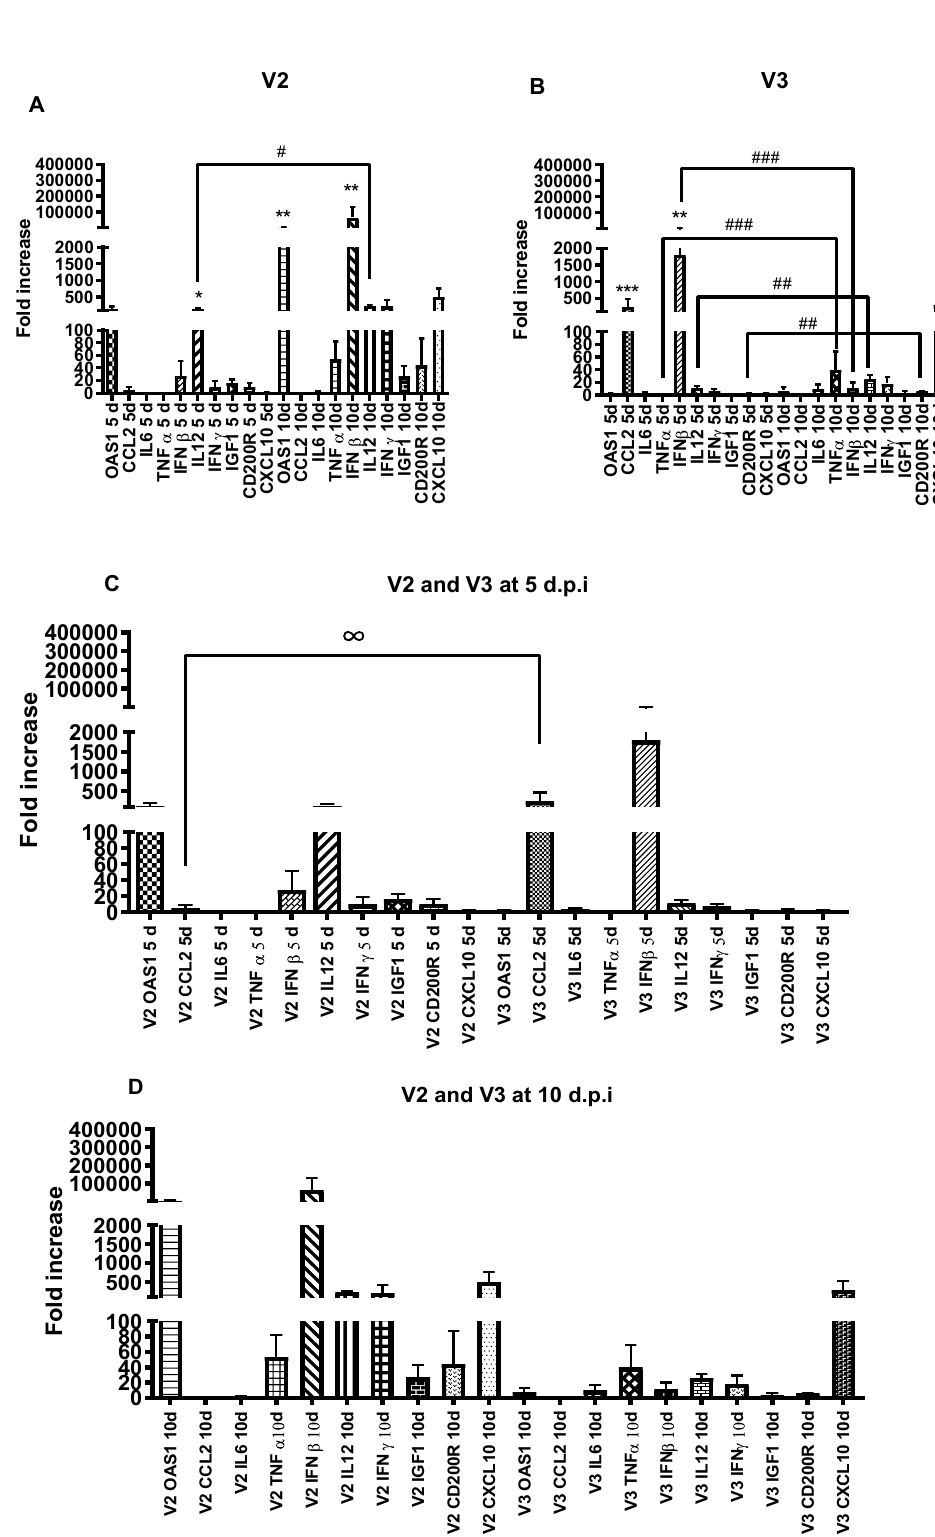
Figure 3. Relative gene expression of cytokines and chemokines in both groups (V2 and V3) at 5 d.p.i and 10 d.p.i. Kruskal–Wallis test was applied to analyze the global results and Mann–Whitney two-tailed test was applied to make individual comparisons at 5 vs. 10 d.p.i. ( A ) Expression at 5 and 10 d.p.i. in the V2 group. * p < 0.05; ** p = 0.01; # p = 0.09. ( B ) Expression at 5 and 10 d.p.i. in the V3 group. ** p < 0.01; *** p < 0.001; ### p = 0.0005; ## p = 0.0047. ( C ) Expression at 5 d.p.i. in V2 and V3. ∞ p < 0.01. ( D ) Expression at 10 d.p.i. in V2 and